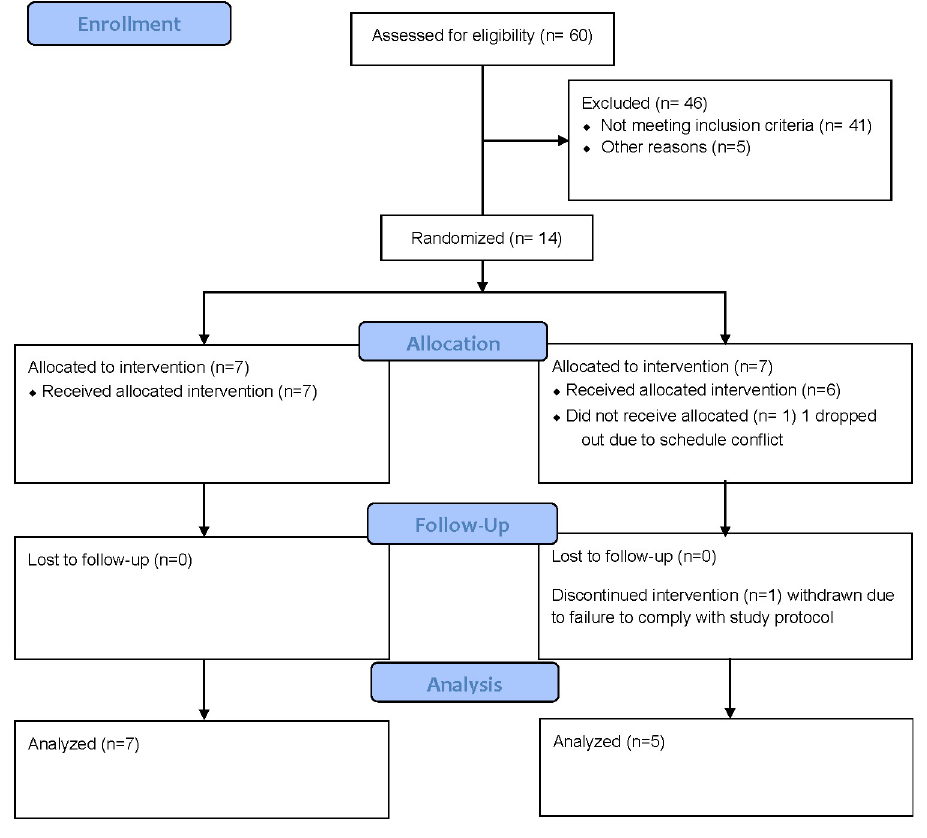
Fig 1. Flow diagram for the study